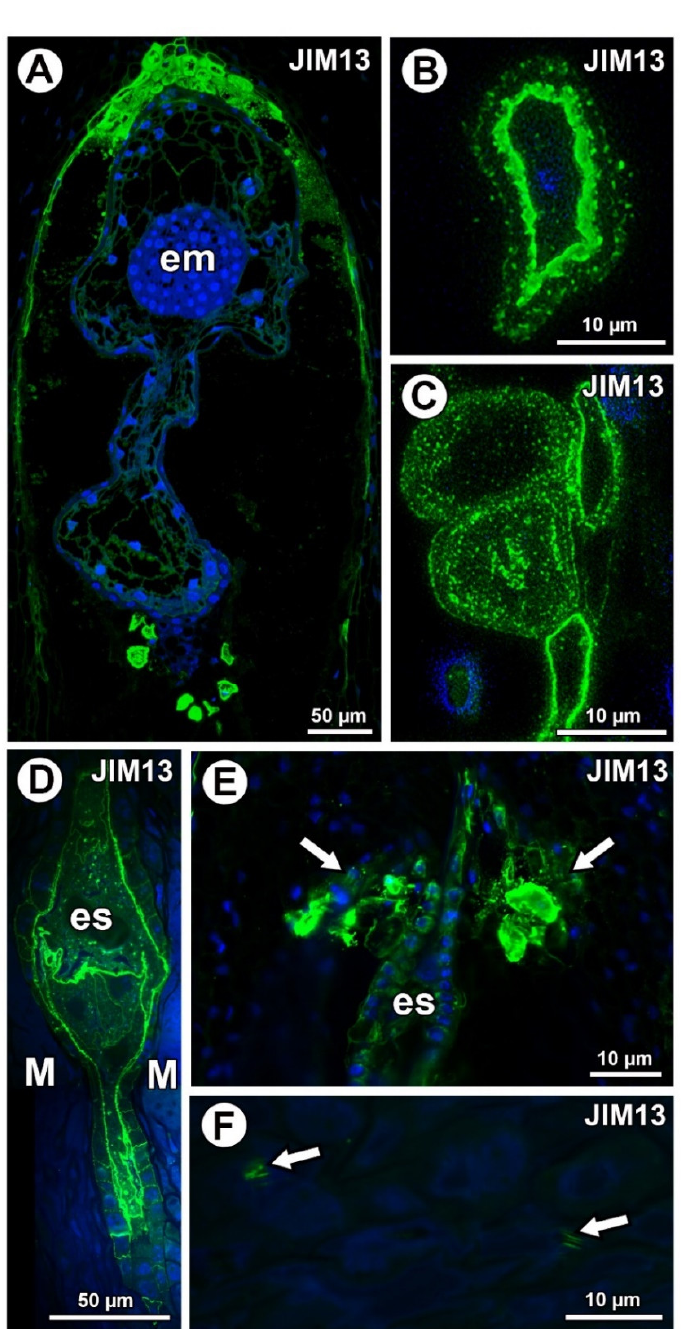
Figure 4. Arabinogalactan protein (labeled with JIM13) detection. ( A ) Sections through the young seed of Taraxacum officinale ; note the presence of embryo (em). ( B , C ) AGP detection in mucilage cells in the young seed of T. o ffi cinale ; note several distinct layers in the mucilage. ( D , E ) Occurrence of AGPs in embryo sac (es), endothelium, and in group of mucilage cells at micropylar pole (arrows) in Pilosella o ffi cinarum ovules. ( F ) Association between AGPs and calcium oxalate crystals (arrows) in ovule parenchyma cells of P. o ffi cinarum